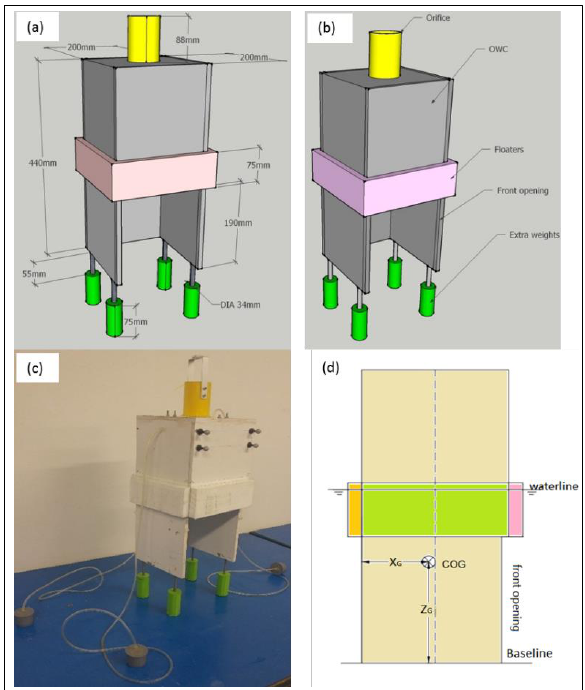
Figure 3. The OWC WEC scale model: ( a ) 3D sketch showing all basic dimensions; ( b ) 3D sketch showing all important parts; ( c ) photo of the actual model with reflective markers attached; ( d ) cross-section along the middle X – Z plane and center of gravity (COG).